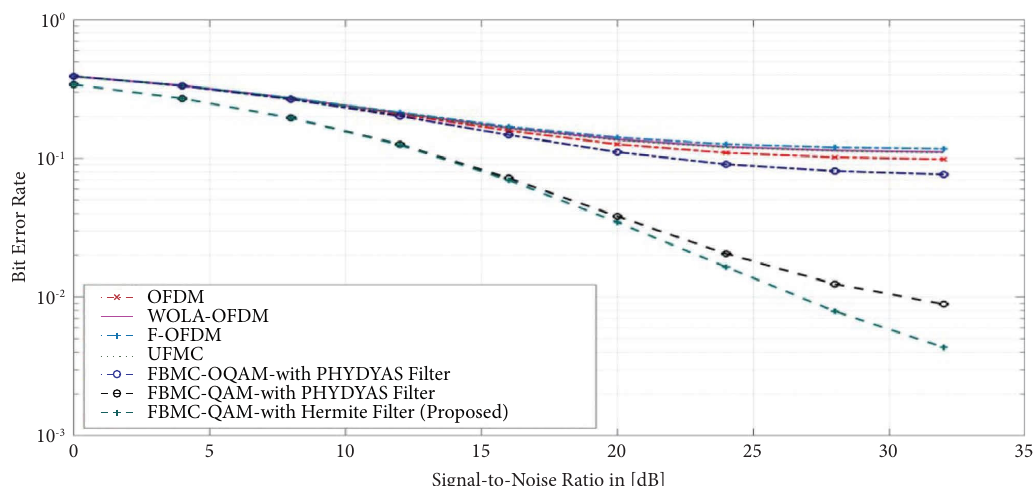
Figure 12: Bit error rate performance of diferent multicarrier modulation techniques for Vehicular B channel model at 64